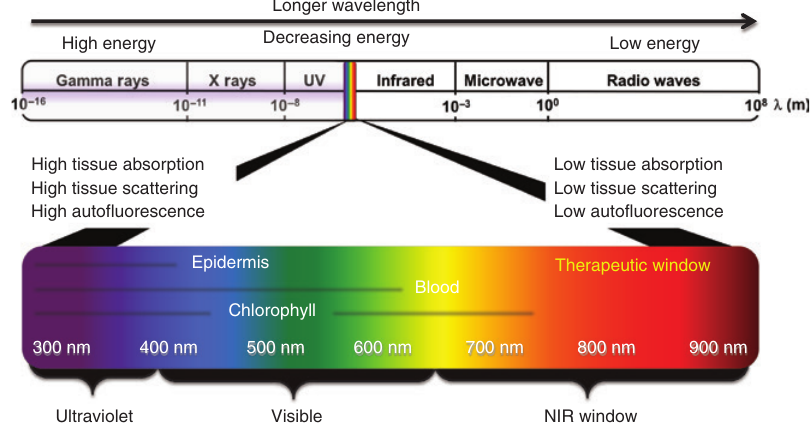
Figure 1: Electromagnetic radiation spectrum from gamma rays to radio waves. The fluorescence wavelength includes UV (200–400 nm), visible radiation (400–650 nm), and NIR (650–900 nm). The NIR window is considered as the therapeutic window due to the low tissue absorption, low tissue scattering, and low autofluorescence. Reproduced with permission from